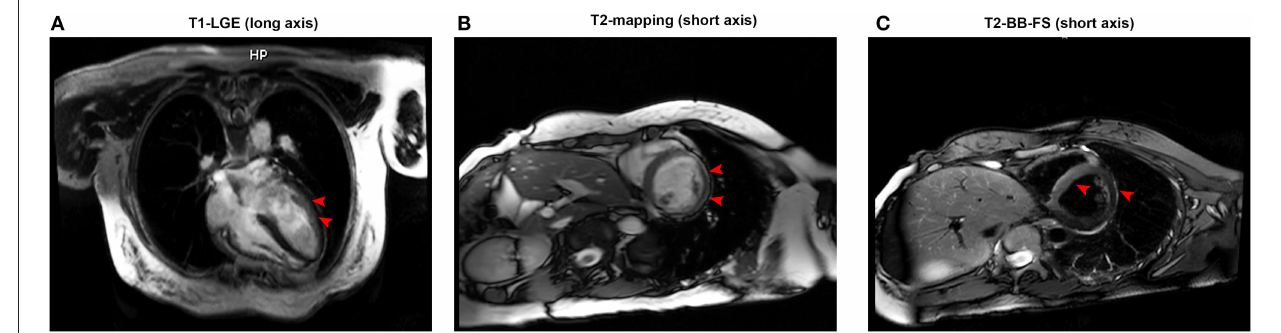
FIGURE 3 | (A) Representative late gadolinium enhancement (red arrow) in the left ventricular anterior wall under T1 imaging (long axis). (B) An enhancement signal (red arrow) appeared in the inferior wall and inferolateral wall of the middle segment of the left ventricle under T2 mapping (short axis). (C) An enhanced signal (red arrow) appeared in the interventricular septum in T2 black blood fat suppression sequences (short